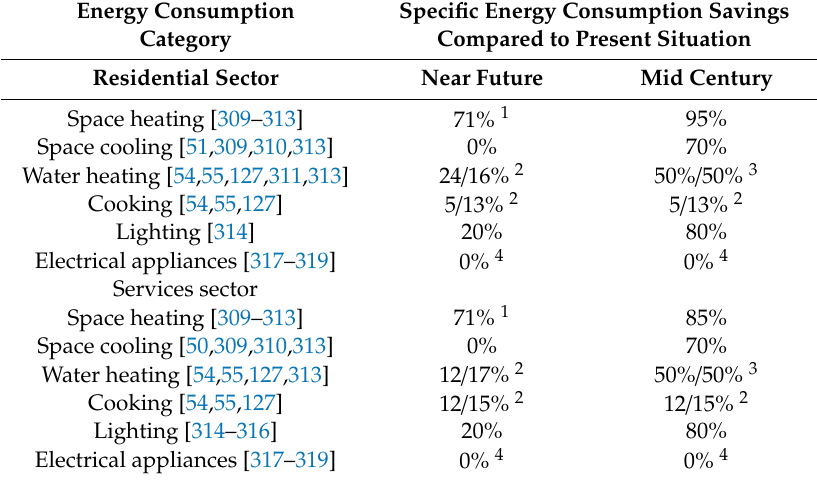
Table A5. Specific energy consumption savings for the Near Future and Mid Century scenarios compared to the Present